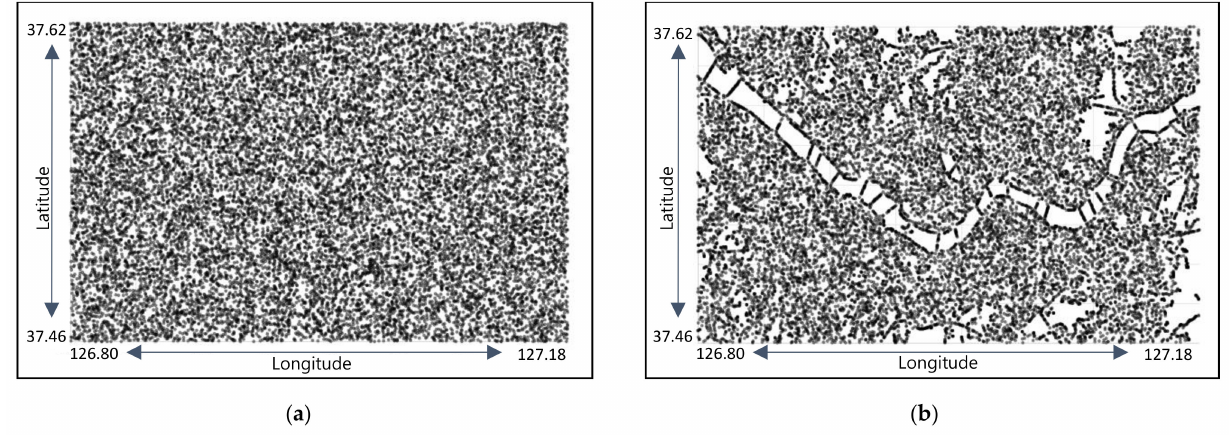
Figure 2. Converting randomly generated points to the closest POIs. ( a ) Random origin–destination points. ( b ) Converted points.